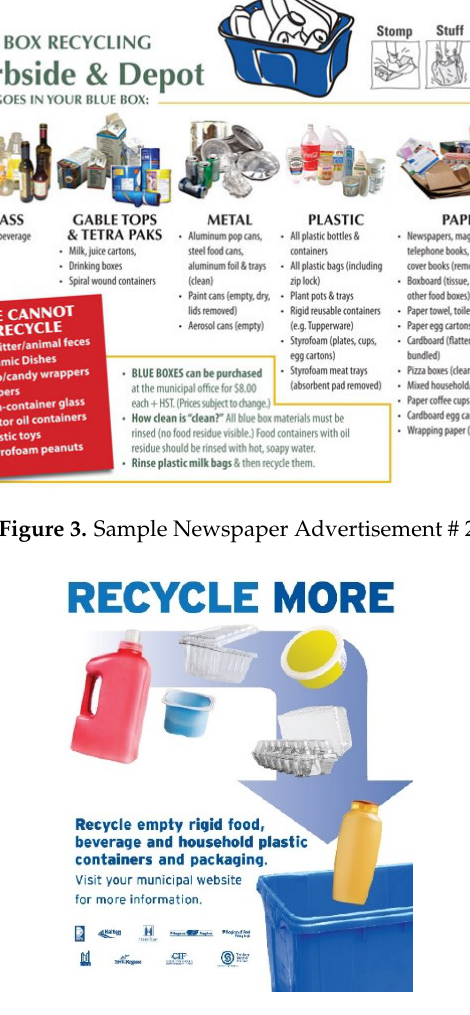
Figure 4. Sample Newspaper Advertisement # 3.